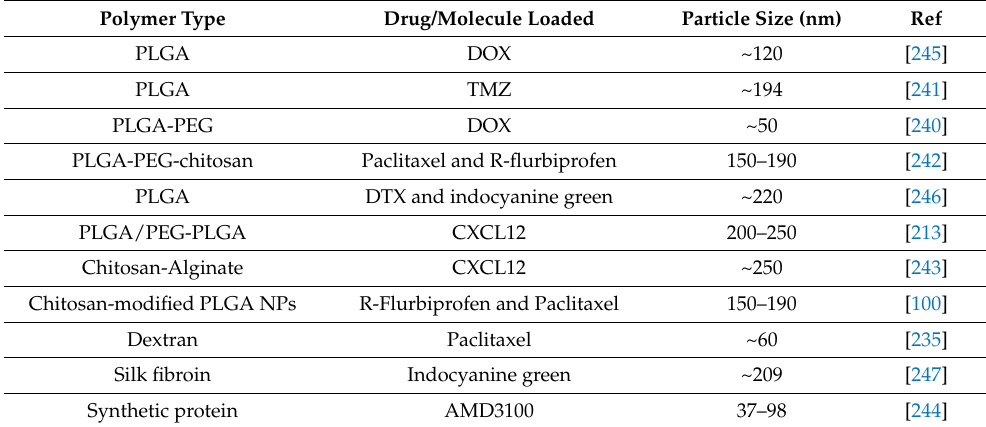
Table 3. Some examples of polymeric-based